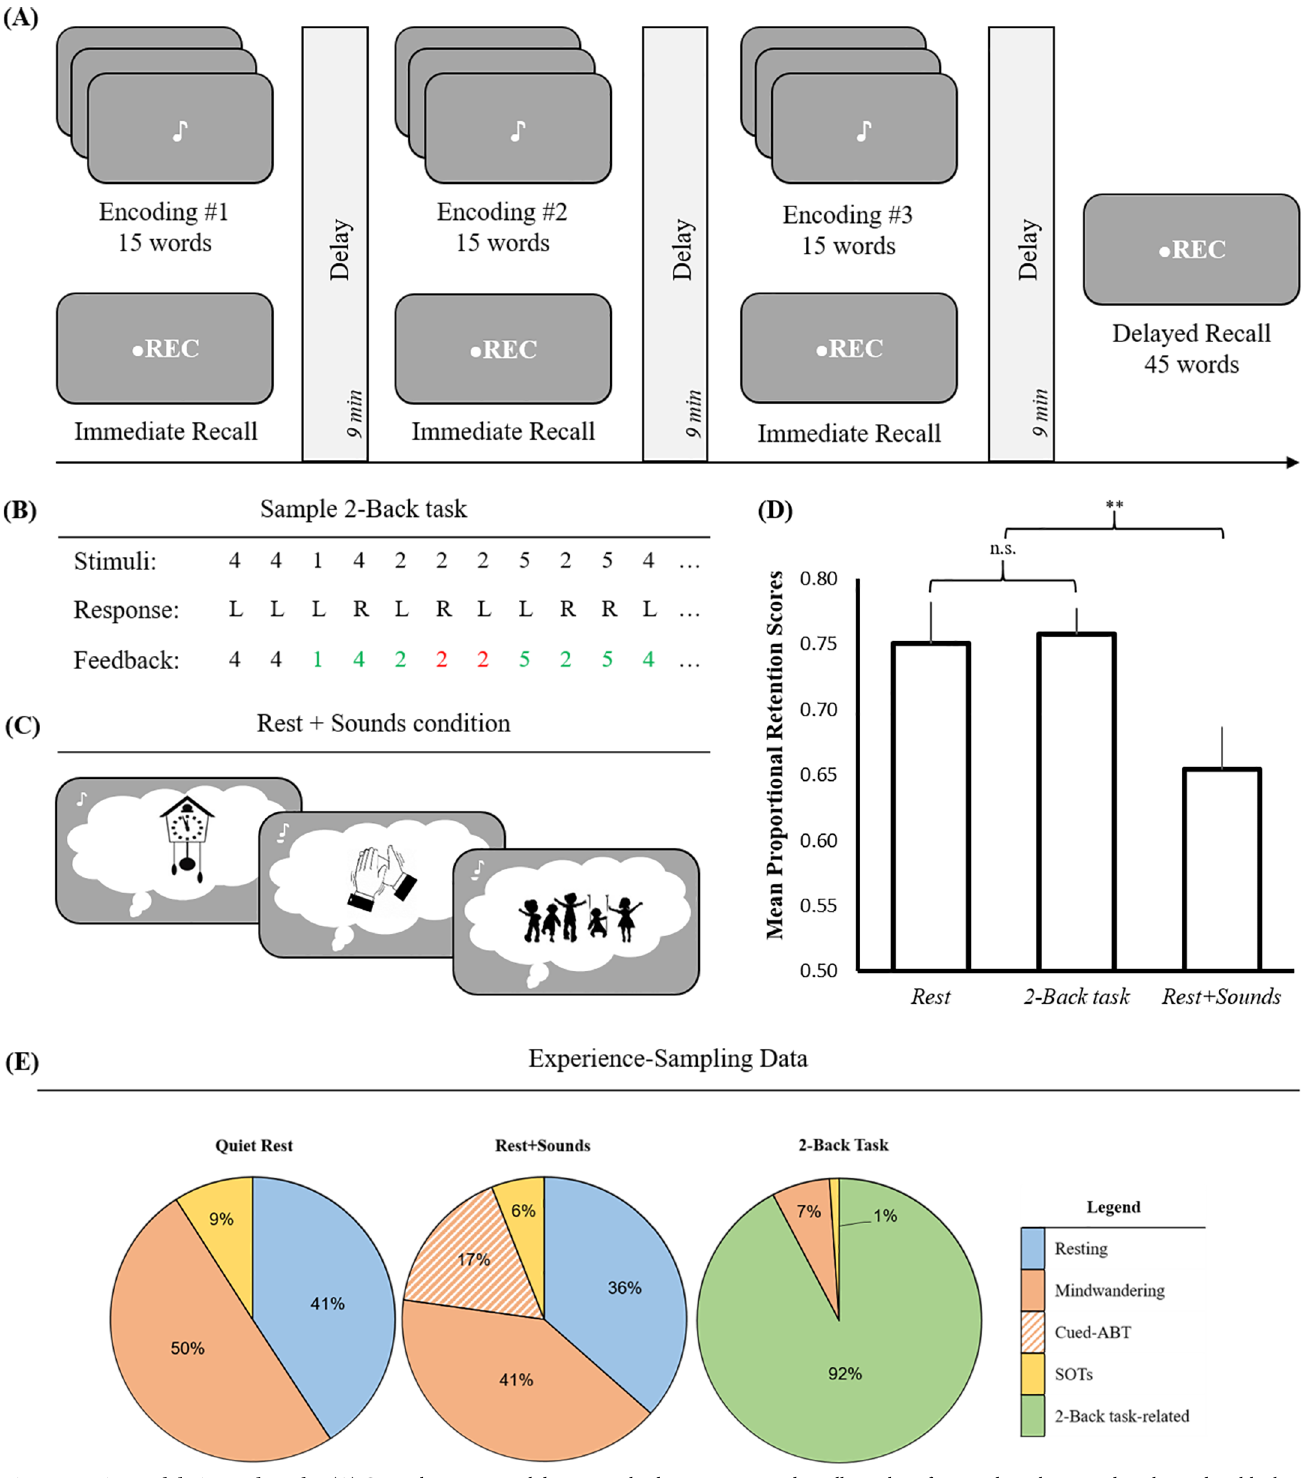
Fig 1. Experimental design and results. (A) General experimental design involved memorizing and recalling a list of 15 words in three incidental encoding blocks. Each encoding block was followed by a delay period occupied either by quiet wakeful rest (rest condition) or rest interspersed with familiar sounds (rest+sounds condition), or a 2-Back task (2-Back condition) in a counterbalanced order across subjects. The duration of these delay periods was set to 9 minutes. At the end of the three encoding-delay sessions, an unexpected delayed recall test measured memory retention of all 45 words. (B) Sample sequence in the 2-back task. ‘L’ and ‘R’